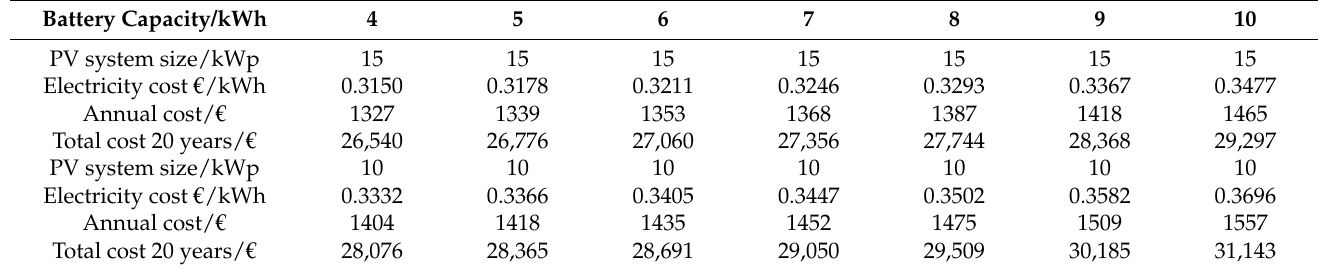
Table 5. Example of cost increase due to installation of larger